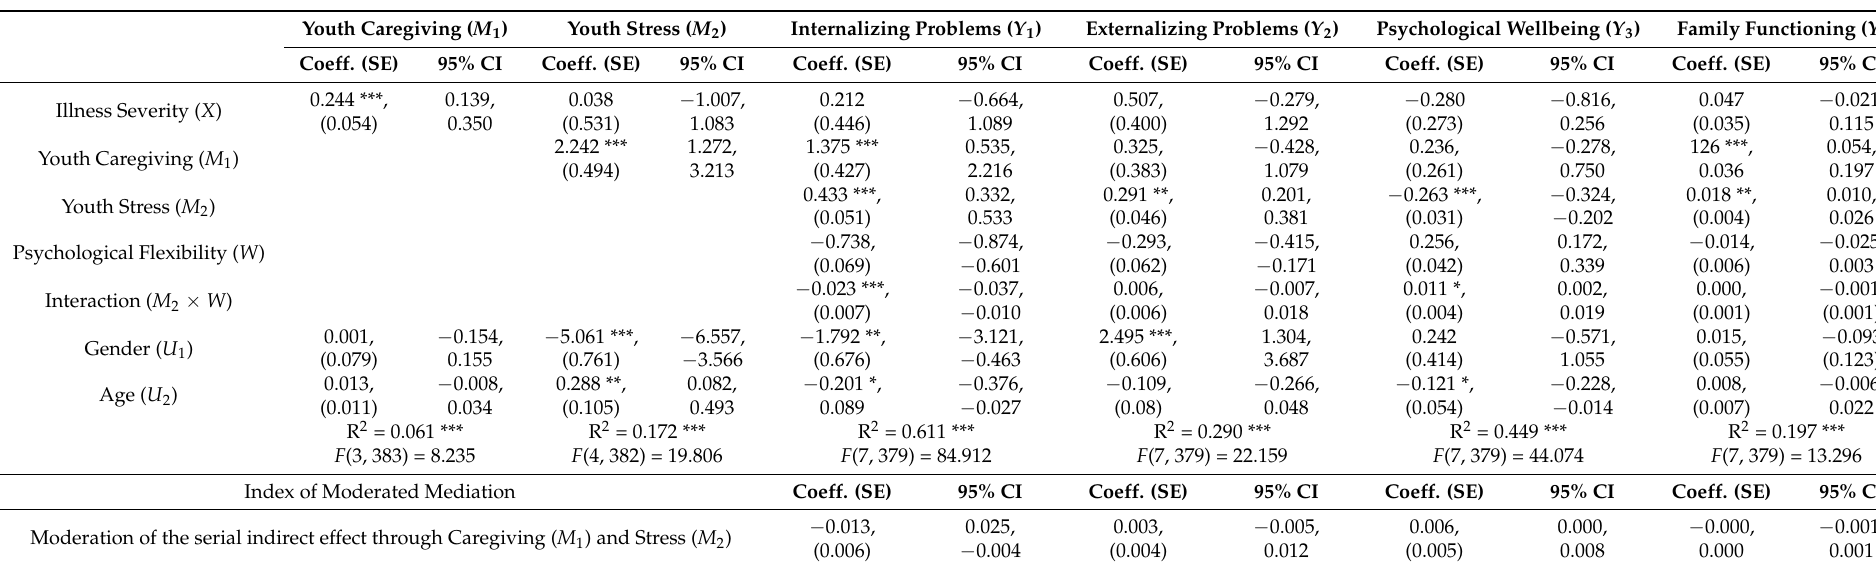
Table 3. Unstandardized coefficients with confidence intervals of each moderated mediation model estimating youth adjustment and family